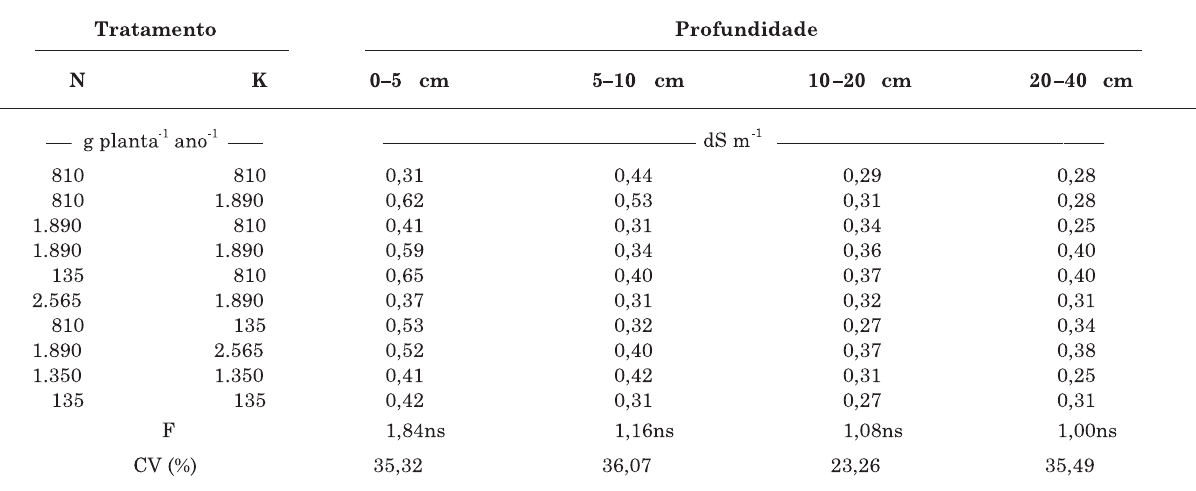
sendo ambos superiores à faixa de 6 a 8 g kg -1 proposta